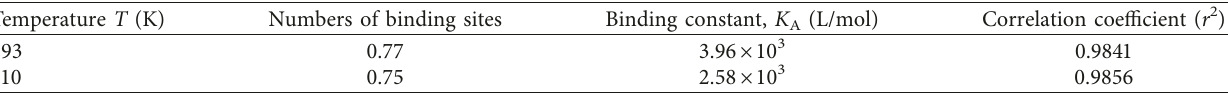
F F/F lg versus lg DBDF2 , 6T at different temperatures: (a) 293K and (b) 310K. 0 [ ] [ ] − − −